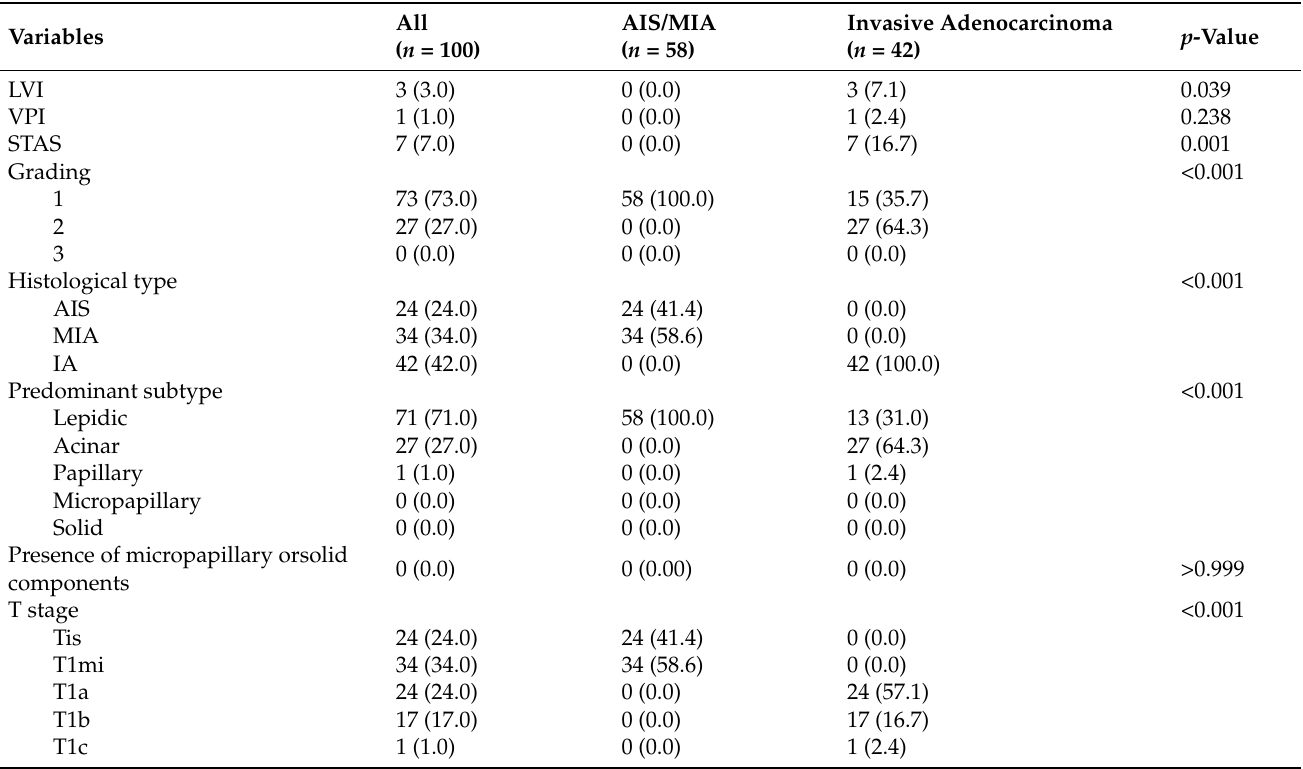
Table 6. Pathological features of the additional pGGN cohort for external